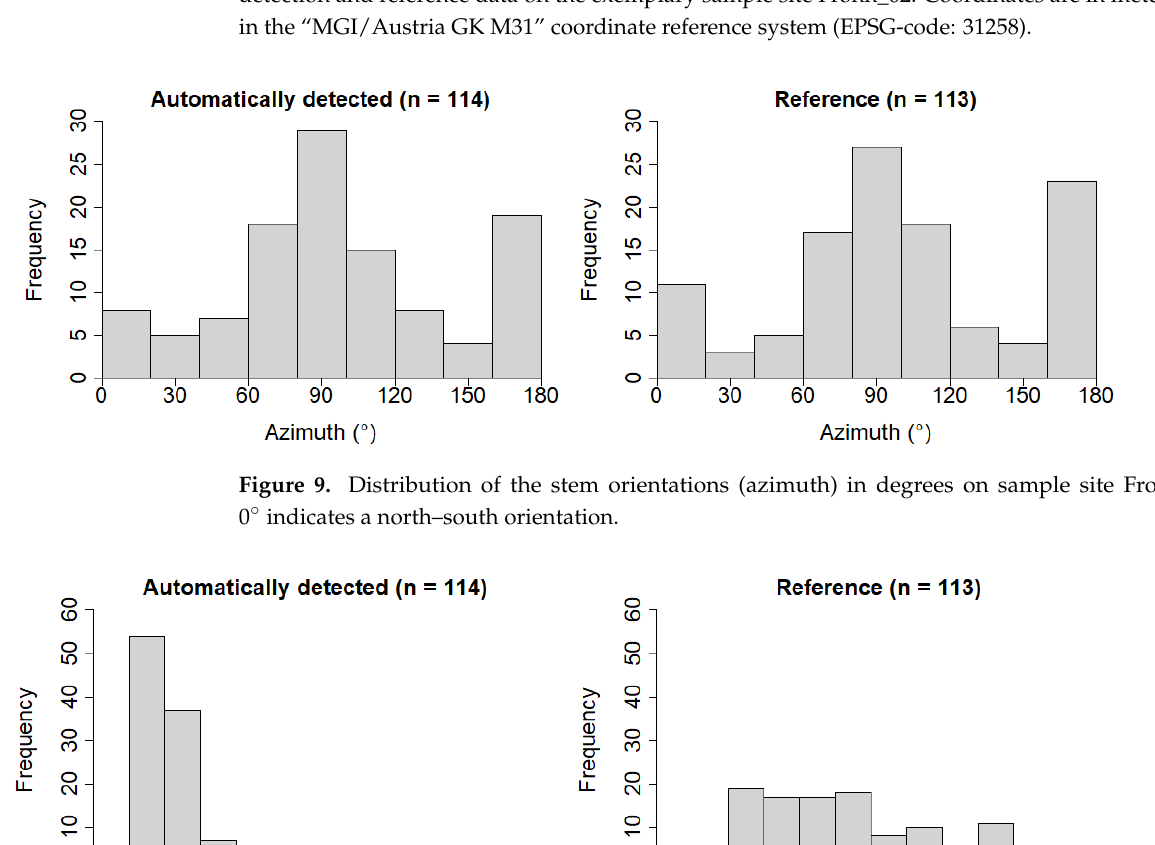
Figure 9. Distribution of the stem orientations (azimuth) in degrees on sample site Frohn_02; 0° indicates a north – south orientation.